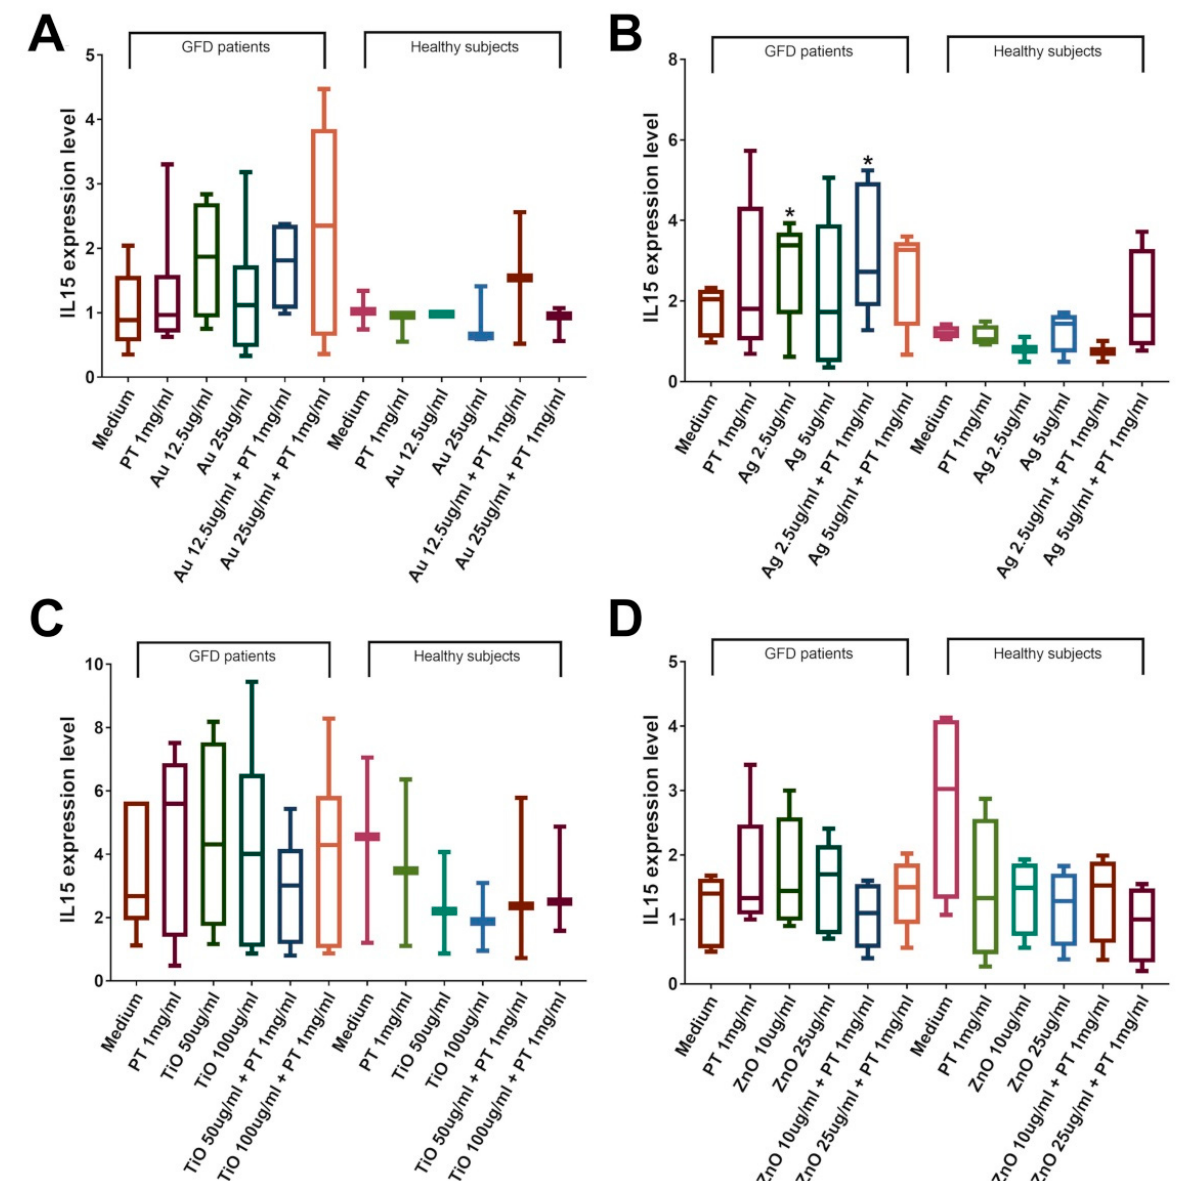
Figure 9. IL-15 expression in CeD patients on a GFD and healthy controls. Significance versus untreated biopsies is indicated above each column (* p < 0.05), whereas versus PT is represented by bars. Duodenal biopsies stimulated 4 h with PT 1 mg/mL ± ( A ) AuNPs 12.5/25 µ g/mL (GFD n = 6; Healthy n = 3); ( B ) AgNPs 2.5/5 µ g/mL (GFD n = 6; Healthy n = 4); ( C ) TiO2NPs 50/100 µ g/mL (GFD n = 7; Healthy n = 4); ( D ) ZnONPs 10/25 µ g/mL (GFD n = 5; Healthy n = 4). Box plots represent median, 25th, and 75th percentiles. Whiskers indicate 5th and 95th percentiles.